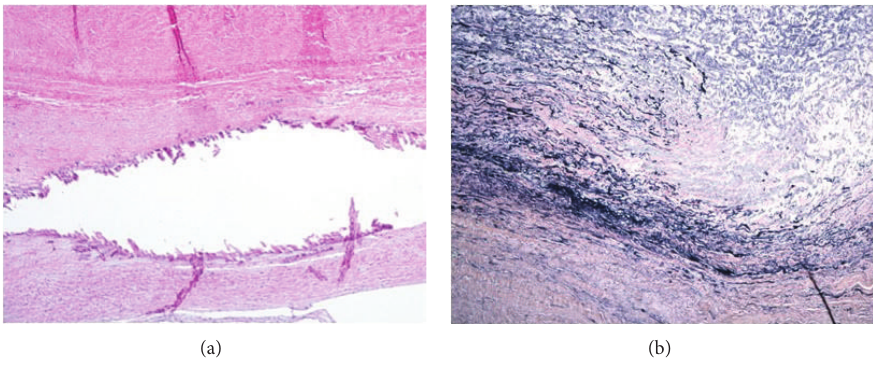
Figure 2: (a) Ascending aorta: medial fibrosis and dystrophic calcification (Hematoxylin and Eosin) and (b) fragmentation and disorganization of the elastic fibers (Verhoeff Van Gieson’s elastic stain).